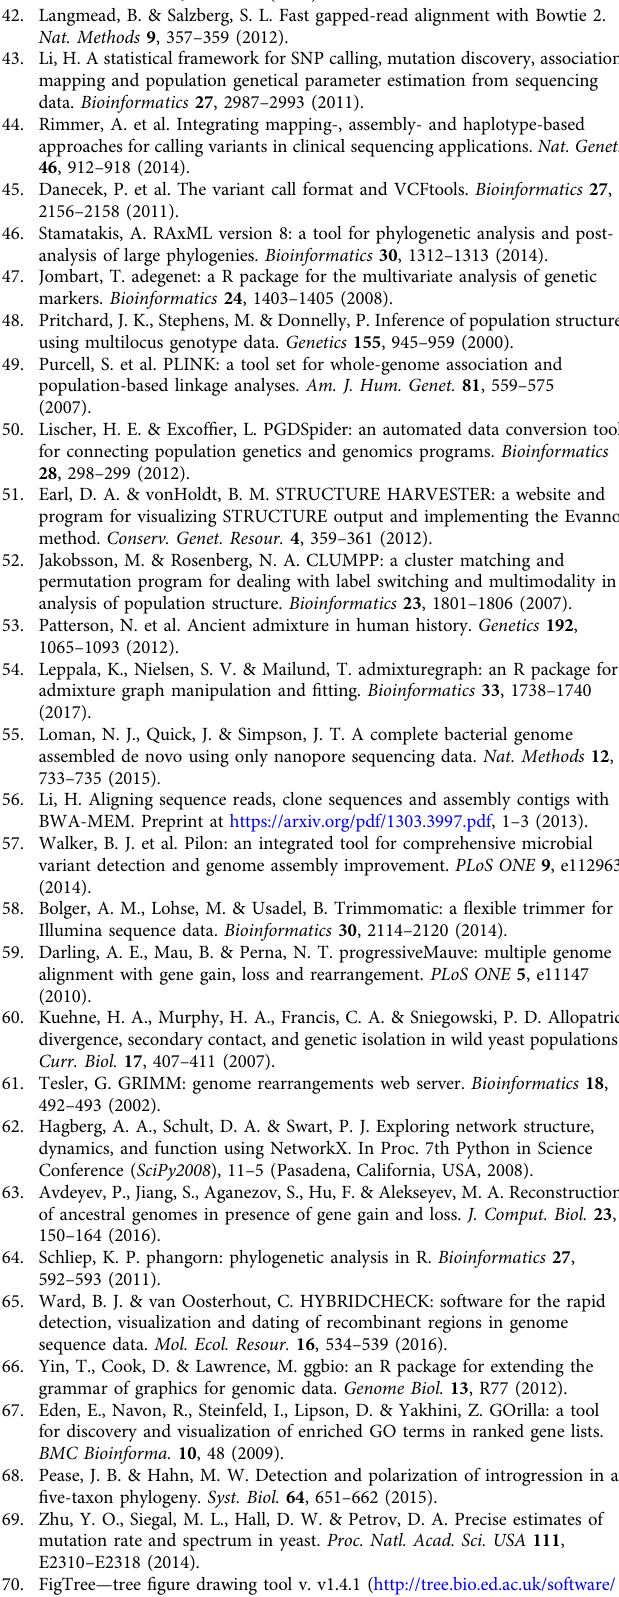
70. FigTree — tree fi gure drawing tool v. v1.4.1 (http://tree.bio.ed.ac.uk/software/ fi gtree/,